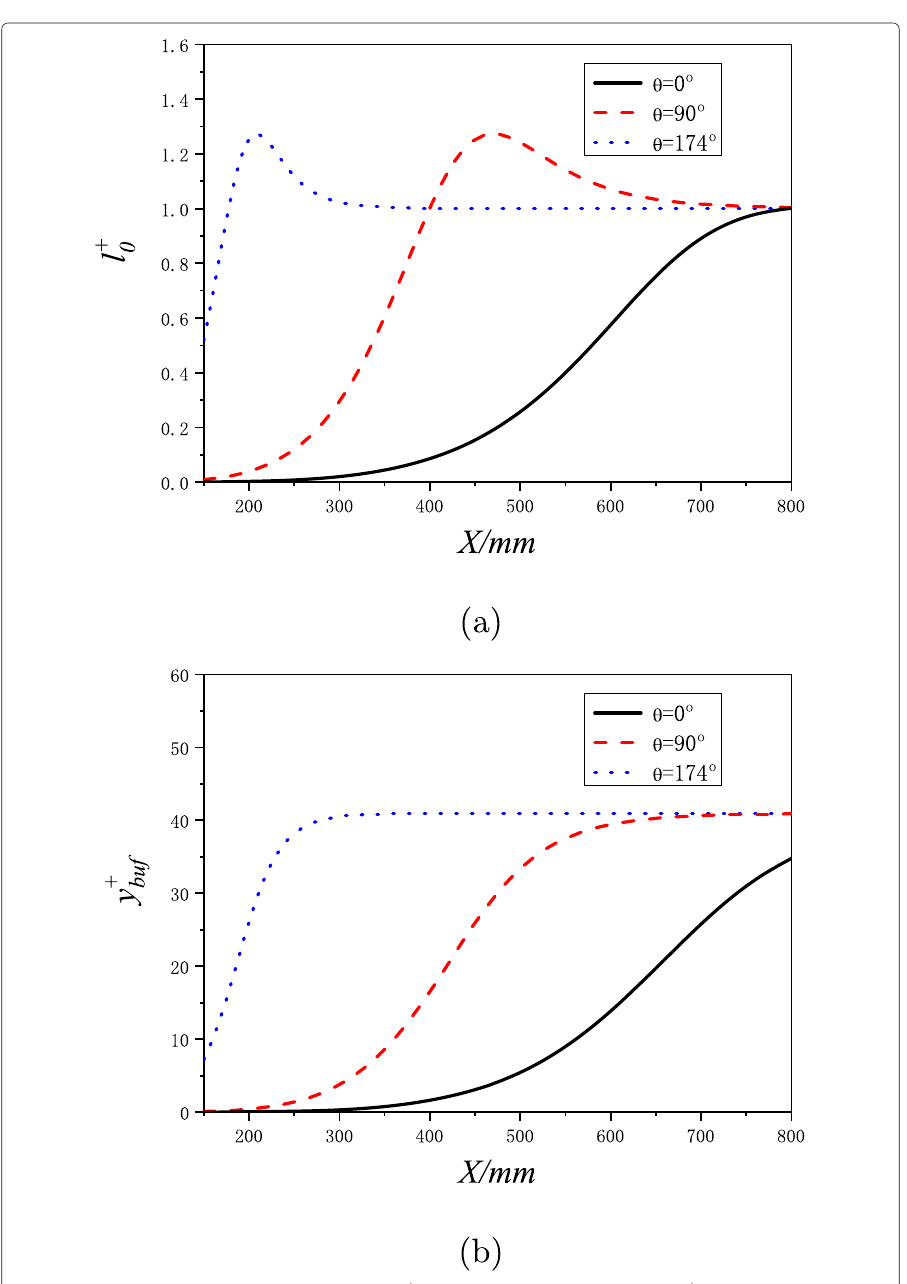
Fig. 5 Evolution of a the near wall eddy length (cid:6) + 0 and b the buffer layer thickness y + meridian lines for the GAC-6